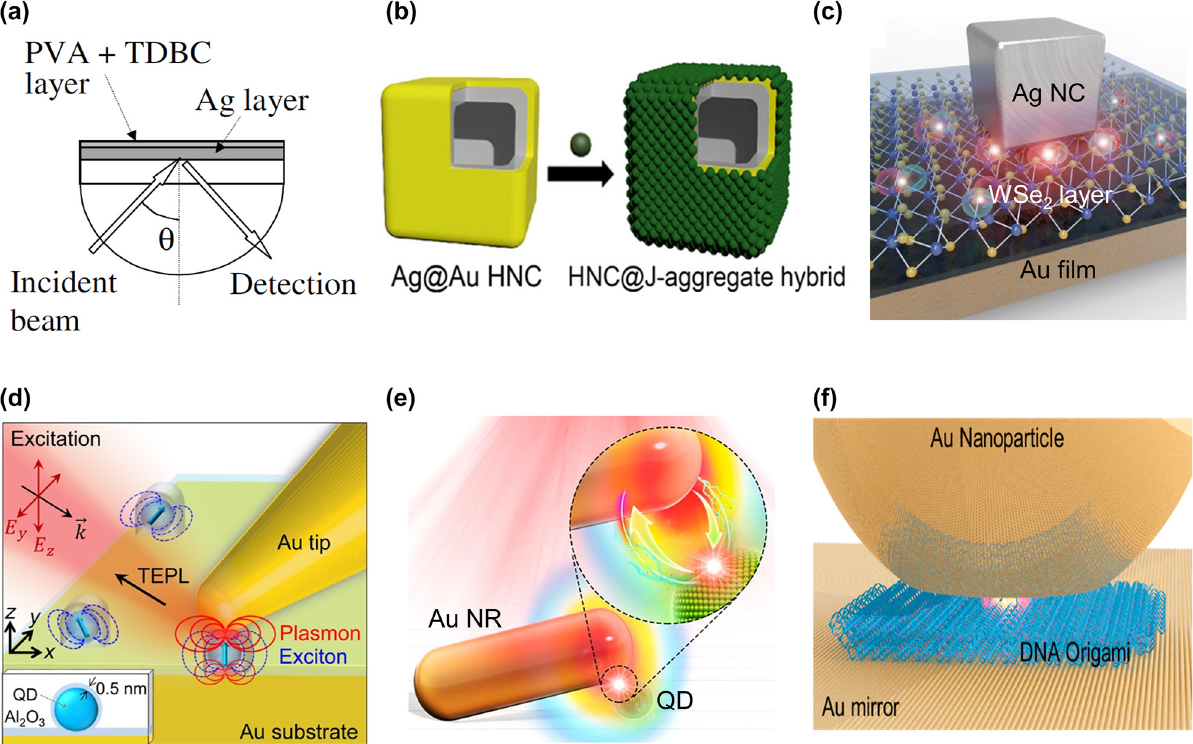
Figure 2: Diverse arrangements of nanostructures for plexcitonic strong coupling. (a) Ag film with 50 nm thickness and a TDBC J-aggregate monolayer between Ag nanocube covered layer on a hemispherical prism. (b) Ag@Au hollow nanocube coated with J-aggregates. (c) WSe 2 PVP layer and Au film mirror. (d) QDs in the space between Au mirror substrate and Au tips with several nanometer apex radii. (e) Wedge nanogap composed of Au nanorod and QD on a carbon film substrate. (f) Using DNA origami, a single molecule is placed in the middle of the gap between the Au nanoparticle and the Au mirror. The pictures are reproduced with permission: (a) Ref. [41] © 2004 American physical society. (b) Ref. [80] © 2022 American chemical society. (c) Ref. [39] © 2018 American physical society. (d) Ref. [45] © 2019 American chemical society. (e) Ref. [121] © 2022 American chemical society. (f) Ref. [117] © 2018 American chemical